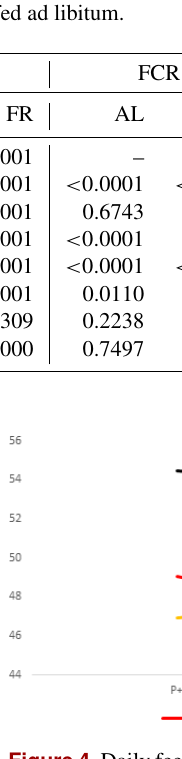
Figure 4. Daily feed intake (grams) per bird (DFI) for infested (P + ) and non-infested (P − ) groups in ad libitum conditions